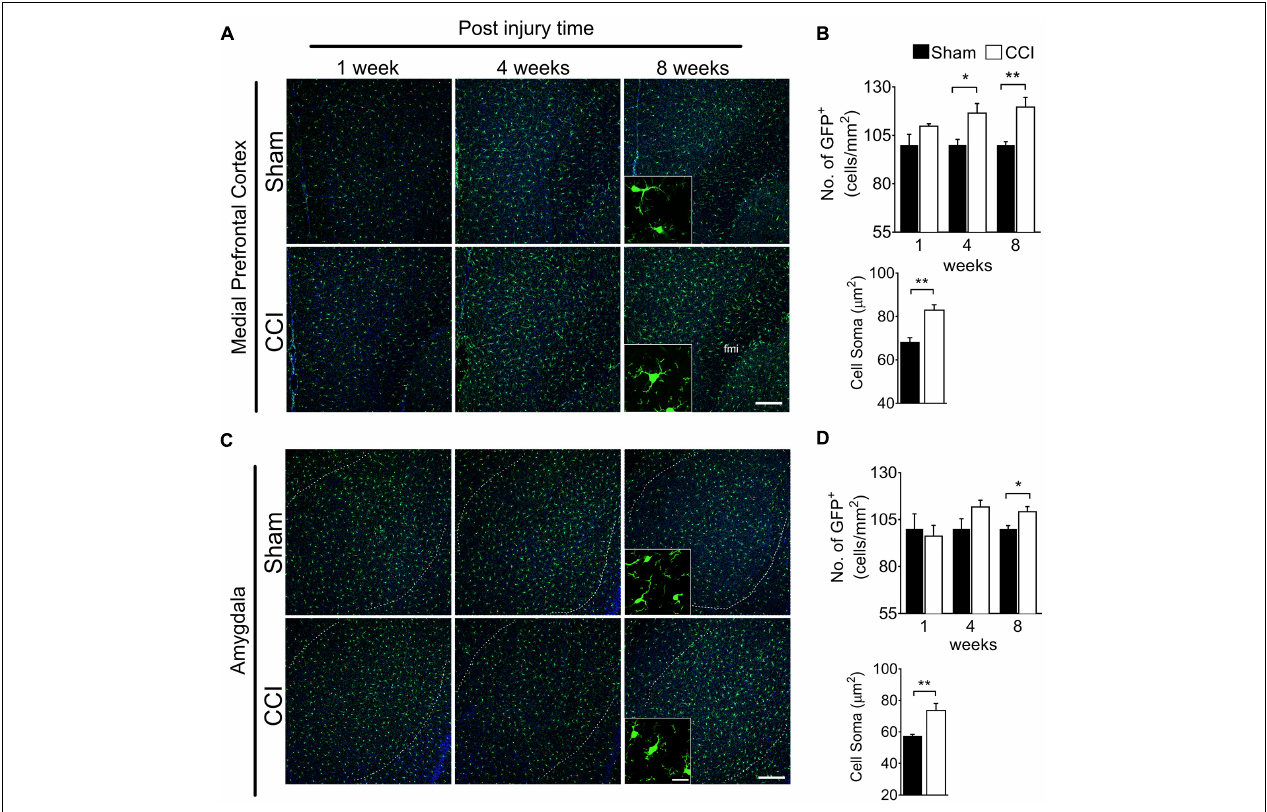
FIGURE 2 | CCI-induced mice showed altered microglial morphology in the mPFC and amygdala at delayed time points. Representative images of (A) mPFC and a high magnification image at 8 weeks (inset) are shown. (B) Quantification of microglial cell number per square millimeter at 1, 4, and 8 weeks ( n = 5, 3–4 tissue sections per animal, mean ± SEM, ∗ p < 0.05, ∗∗ p < 0.01) along with microglial soma area 8 weeks post-injury ( n = 5, 3–4 tissue samples per section, 40 microglial cells, mean ± SEM, ∗∗ p < 0.01) showing significant increases at 8 weeks in the CCI group compared to the sham group. Similarly, (C) representative images of